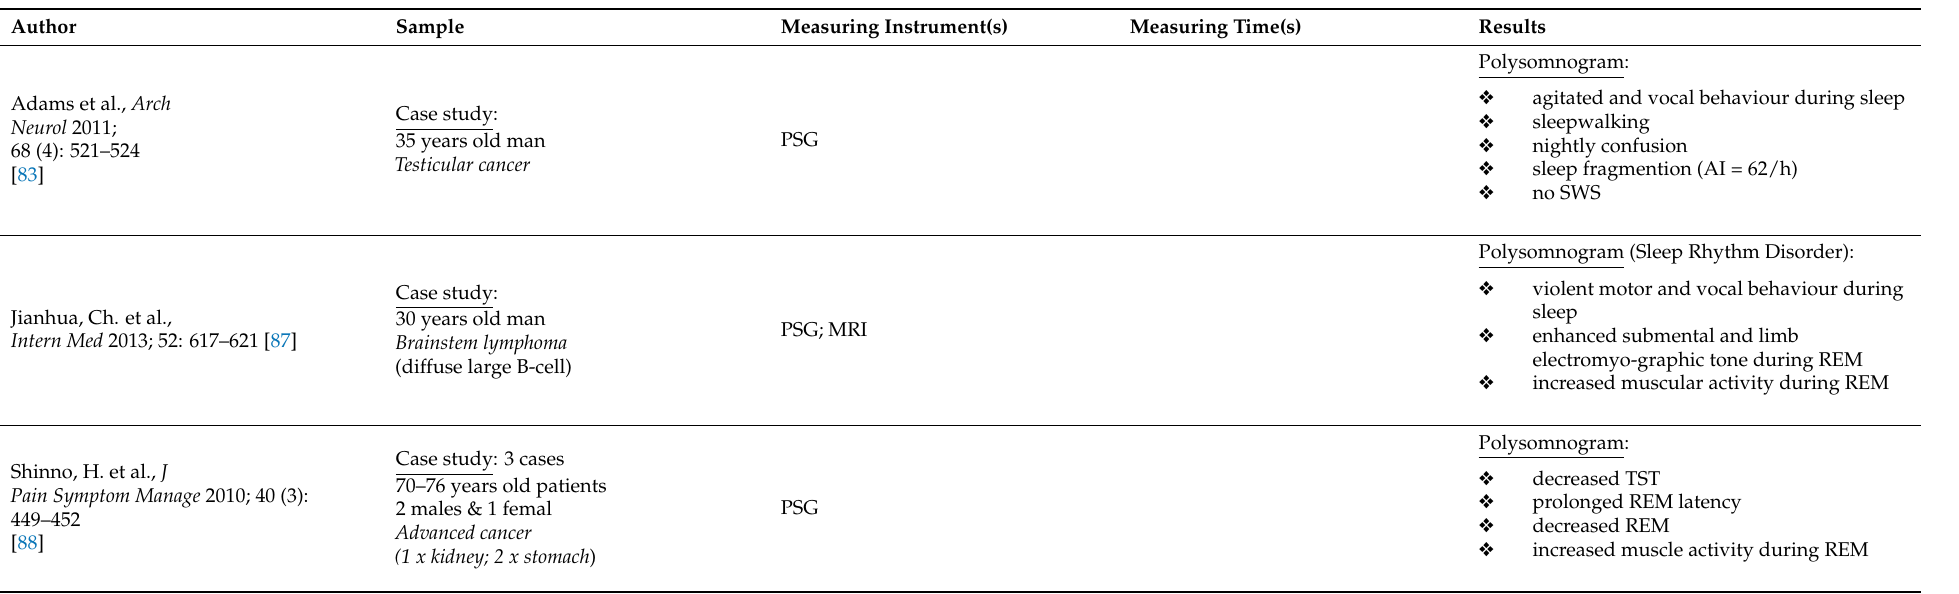
Table 9. Studies on REM Sleep Behaviour Disorder (REM-SBD) in